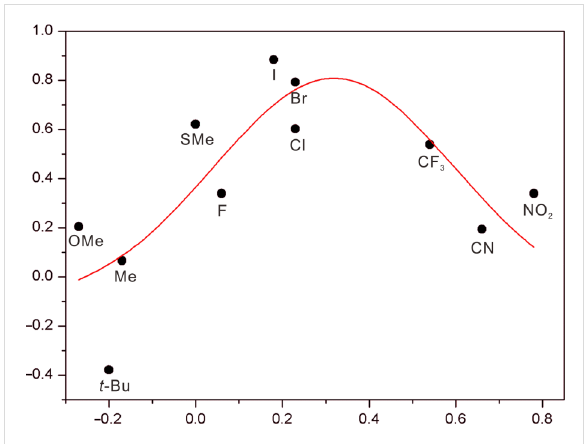
Figure 2: Parabolic free-energy relationship between log( K R / K H ) and Hammett parameter σ p . K R : guests 11 + – 21 + ; K H : guest 3 +